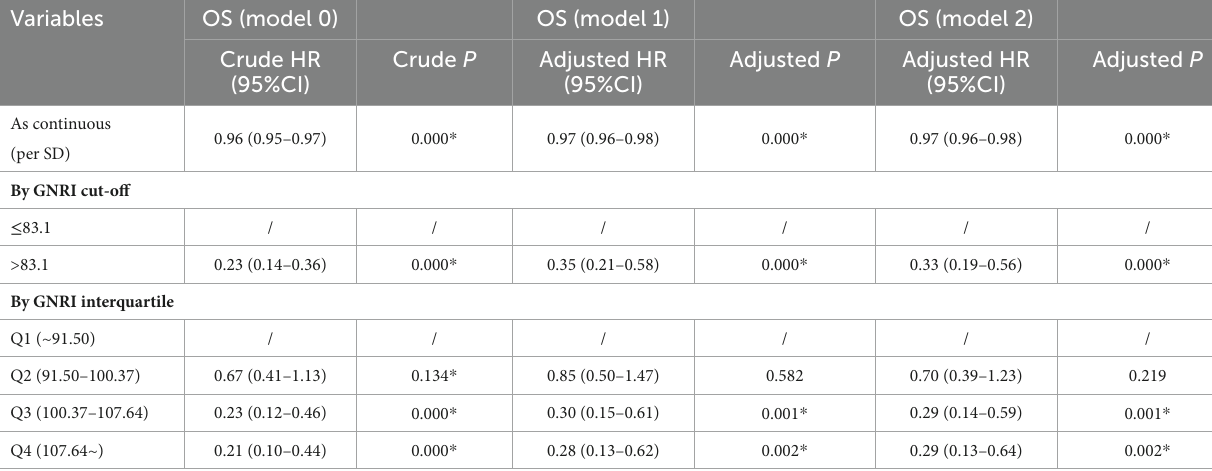
b Model 1: Adjusted for age, gender, BMI and tumor stage. c Model 2: Adjusted for age, gender, BMI, tumor stage, smoking, alcohol, tumor location, differentiated degree, nerve invasion, intravascular tumor emboli, preoperative therapy and postoperative therapy. * p ≤